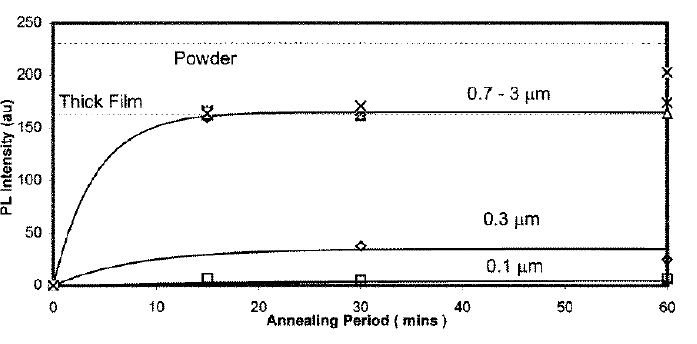
O :Eu phosphor [60]. 2 3